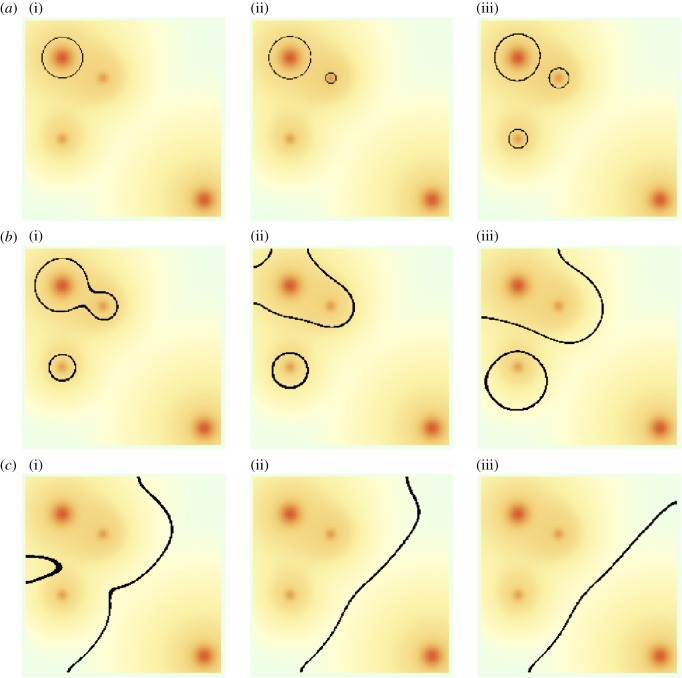
Evolution of a 200×200 system containing four cities. Background colour indicates population density with deep orange/red representing higher-density areas and lighter shades indicating lower density. Large cities have ωi=Ri=10, while small ones have ωj=Rj=5. In all cases, the background radius is five times the city radius. The system is initialized with one large city (a(i)) using variant A and all others using B. Model parameters are σ=22,γ=25,β=1.1. There is no inherent bias for or against either variant (α=1). Black lines represent isoglosses: f(x,y,t)=12. Images correspond to evolution times t=1,3,10 (a(i–iii)); then t=40,80,120 and 160,200,300, respectively.